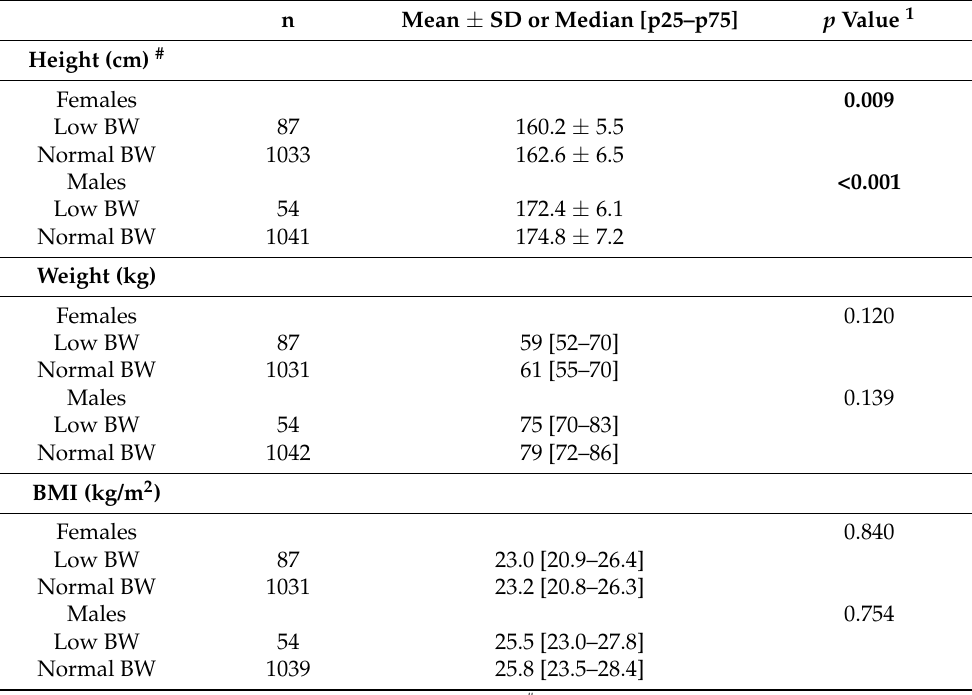
Table 2. Height, weight and BMI measures by birthweight and sex.